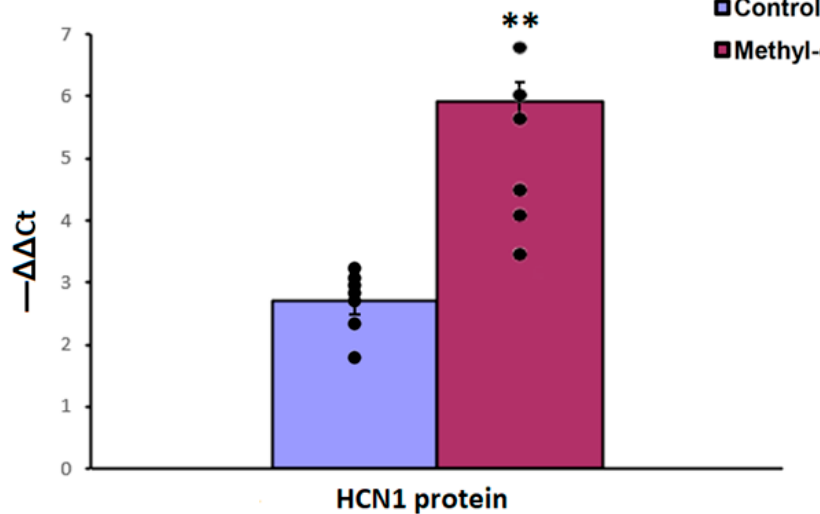
Figure 8. The protein expression levels of the HCN1 gene in the somatosensory cortex in adult offspring of WAG/Rij rats born to mothers fed a methyl-enriched or control diet. Expression of the DNMT1 protein was determined by western blots in 7 pairs of tissue samples from the control ( n = 10 rats) and experimental ( n = 10 rats) group of animals. Data are the mean ± S.E.M. The individual data points are displayed in bar graphs to show within-group variability. **— p < 0.001 compared with the corresponding values in the control group.